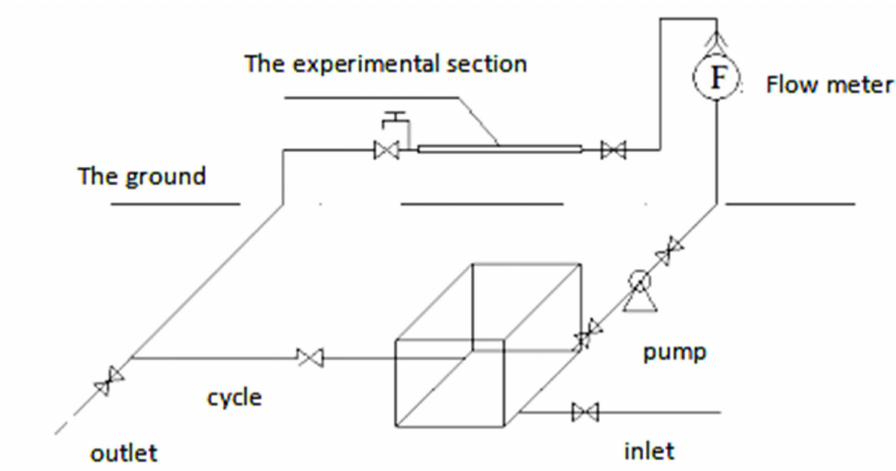
Figure 1. Diagram of test device about dynamic simulation of particle adsorption at different flow